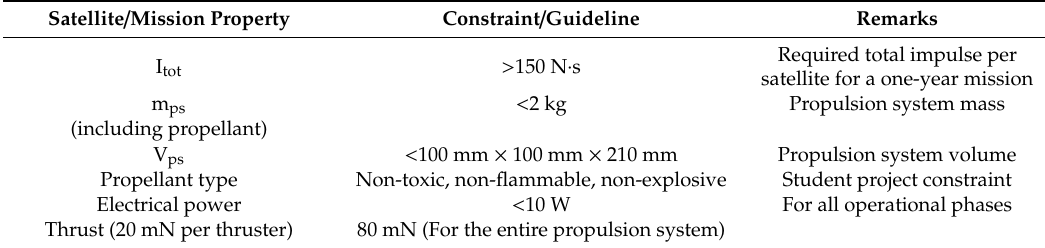
Table 1. Adelis-Space Autonomous Mission for Swarming and geOlocation with Nano-satellites (SAMSON) satellite propulsion system